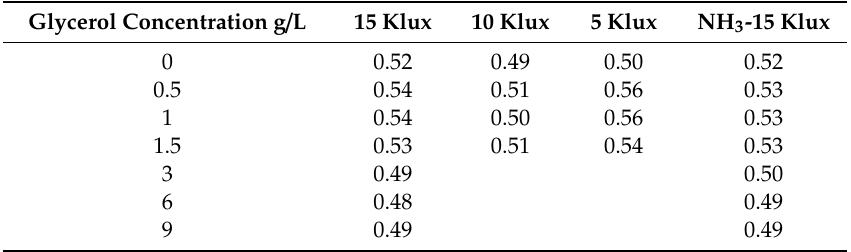
Table 1. Quantum Yield of A. platensis cultivated in the presence of